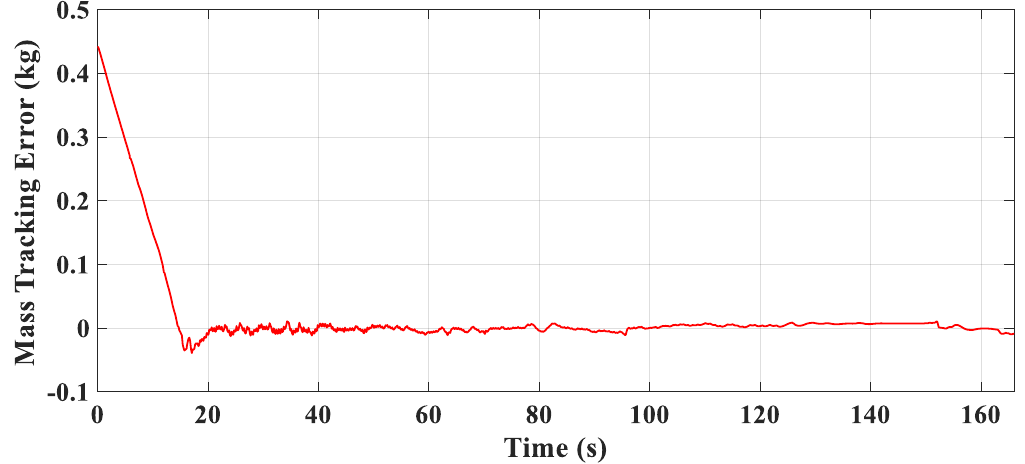
Figure 12. Ballast mass tracking error of hovering control via on-off type VBS.